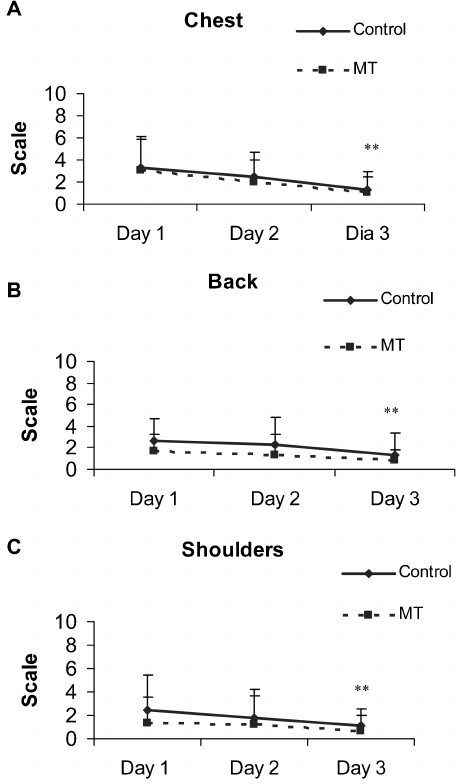
Figure 2 - VAS of pain in chest, back, and shoulders as assessed at the postoperative period on Day 1, Day 2 and Day 3. Intragroup comparison between Day 1 and Day 3 for both groups. (p # 0.05)